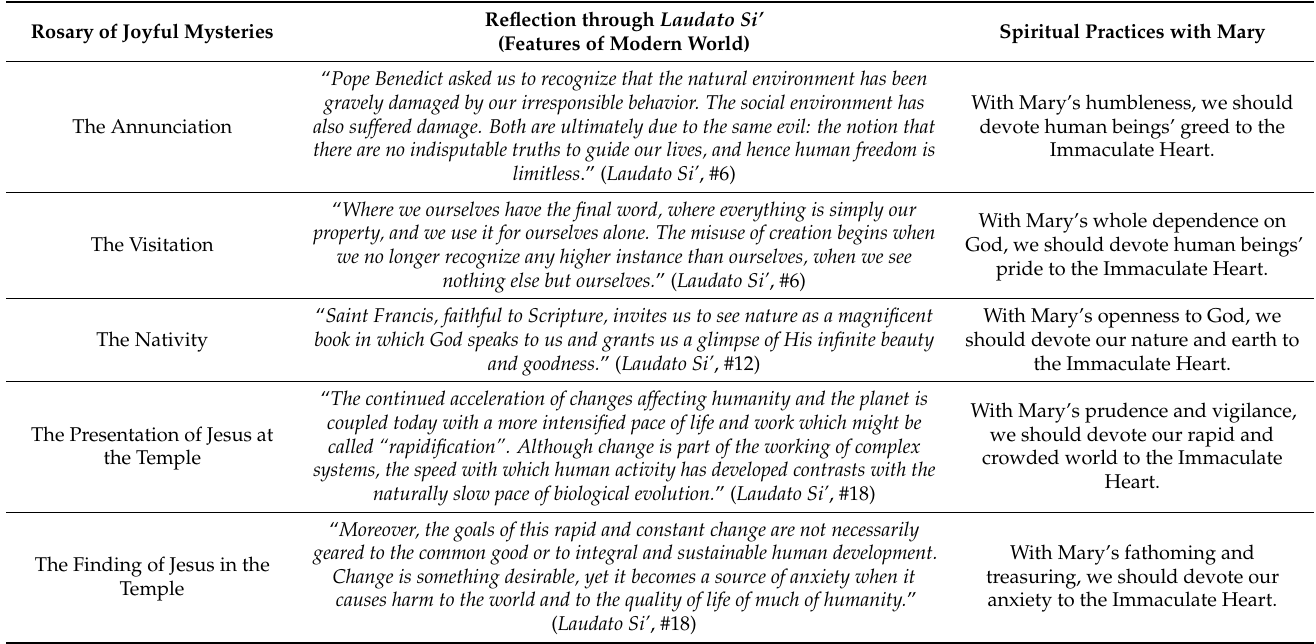
Table 1. Rosary of Joyful Mysteries with Laudato Si’